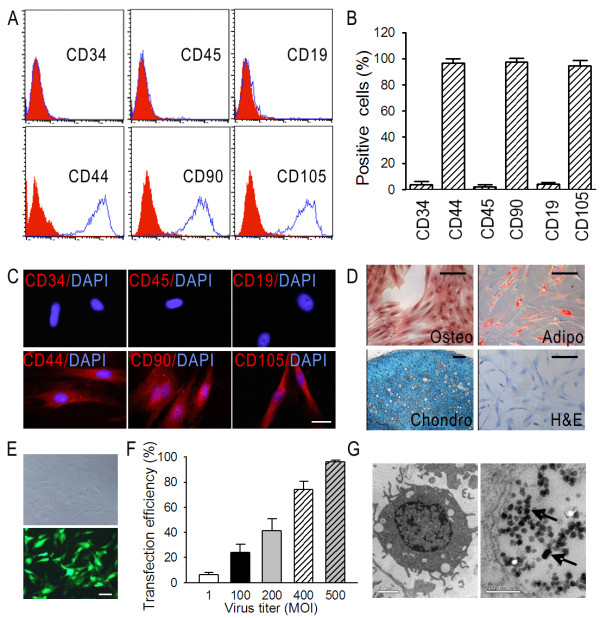
Identification of expanded human MSCs and adenovirus transfection efficiency. (A) Representative histogram overlays of FACS analysis showing the MSC antigen profile. The blue peak represents the specific PE-labeled antibodies: CD34, CD45, CD19, CD44, CD90, and CD105. The red peak represents the corresponding isotope antibodies. (B) Positive expression of CD34, CD45, CD19, CD44, CD90, and CD105 in five independent samples was expressed as mean ± SD as evaluated by FACS. (C) Immunostaining of CD34, CD45, CD19, CD44, CD90, and CD105 in one representative sample as observed under a confocal microscope. Negative controls were performed by using the corresponding isotope antibodies. Red, PE-labeled antibodies; blue, DAPI. (D) Representative photographs showing the in vitro differentiation of MSCs into the osteogenic, adipogenic, and chondrogenic lineages. Undifferentiated MSCs were dyed with hematoxylin and eosin. (E) Representative images depicting the transfection of MSCs with 500 MOI Adv-GFP. Forty-eight hours after transfection, MSCs carrying GFP were observed under bright field (upper panel) and fluorescent field (lower panel). (F) Transfection efficiencies at different Adv-GFP titers after 48 hours in three independent MSC samples were expressed as mean ± SD as evaluated by FACS. (G) Electron micrographs showing viral particles in MSCs. MSCs were infected with 500 MOI Adv-Stat3(-). Seventy-two hours later, MSCs were collected and prepared to be observed under an electron microscope. Adenovirus particles in the MSCs were shown using the black arrow. C, scale bar = 5 μm; D, scale bar = 10 μm; E, scale bar = 10 μm; G, left scale bar = 2 μm, right scale bar = 200 nm).